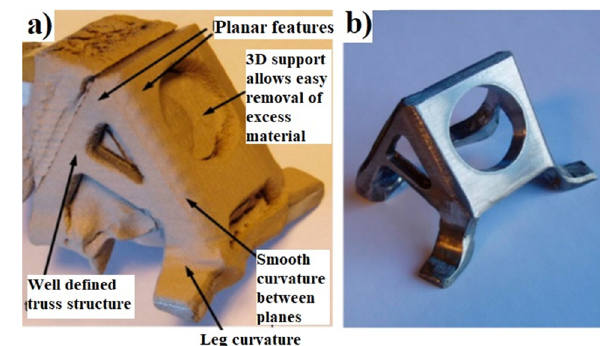
Figure 11: Fragments of bimetal Ti – 6Al – 4V/Al and Ti/Cu plates manufactured through CS process and machining is made by milling after deposition [ 55 ] .